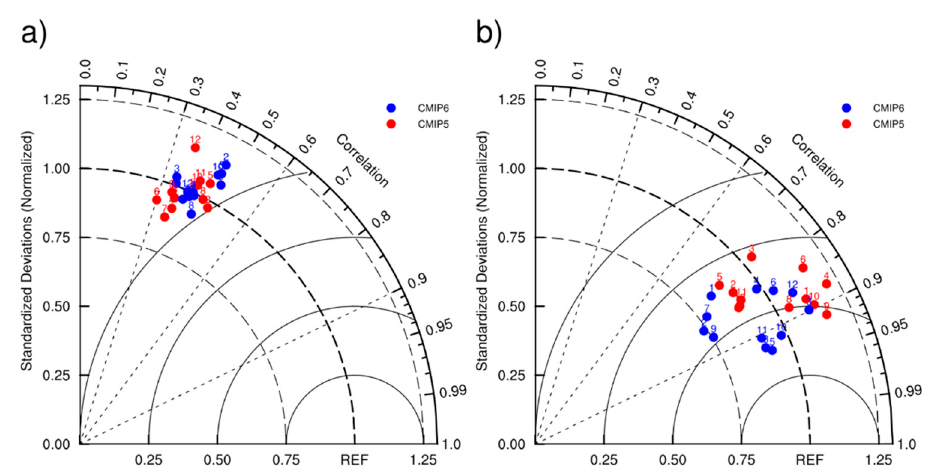
Figure 1. Taylor diagrams of ( a ) sea-level pressure (SLP) and ( b ) sea surface temperature (SST) simulated by the 12 CMIP5 models and 12 CMIP6 models with ERA5 as the reference data.